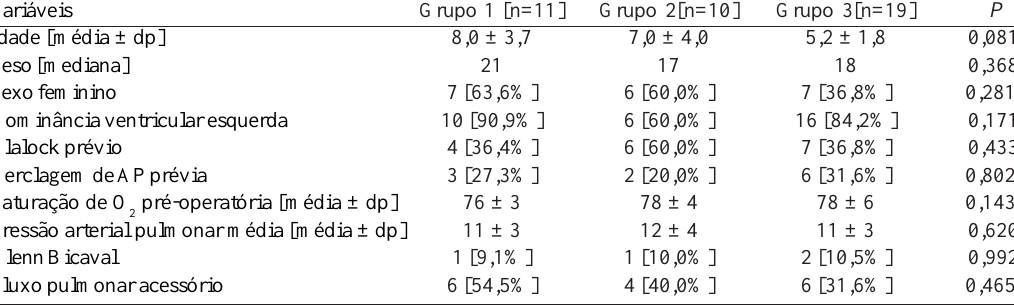
Tabela 2. Comparação das variáveis pré-operatórias nos três grupos Variáveis